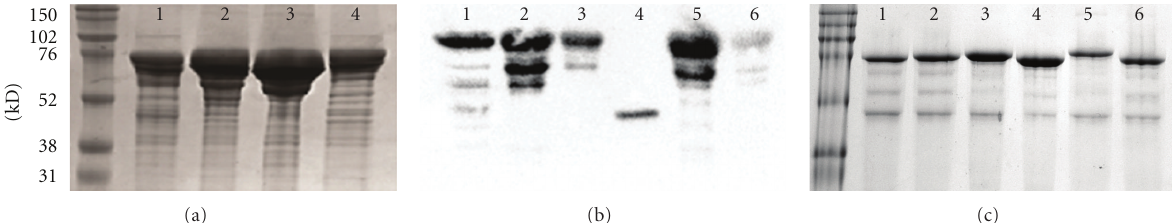
Figure 5: Purification of huPON1 variants from E. coli . (a) SDS-PAGE of purification from His 6 -MBP-PON1 fusions from the pHMT plasmid using NiNTA chromatography. (1) Δ N-huPON1; (2) Δ HDL-huPON1; (3) Δ N- Δ HDL-huPON1; (4) g2e6p-huPON1. (b) Blot of SDS-PAGE of PON1 variants as His 6 -MBP-PON1 fusions with HisProbe-HRP (Pierce), demonstrating that many of the smaller proteins bear the 6 × His tag and are likely proteolytic fragments. (1) Δ HDL-huPON1 lysate; (2) and (3), purified Δ HDL-huPON1; (4) cleaved MBP; (5) purified g2e6p-huPON1; (6) purified Δ N-huPON1. (c) SDS-PAGE of purified proteins from the MBP-PON1-His 6 constructs in pET11a with coexpression of DnaK/DnaJ/GrpE from pKJE7 (Takara Bioscience). (1) huPON1; (2) Δ N-huPON1; (3) Δ HDL-huPON1; (4) Δ N- Δ